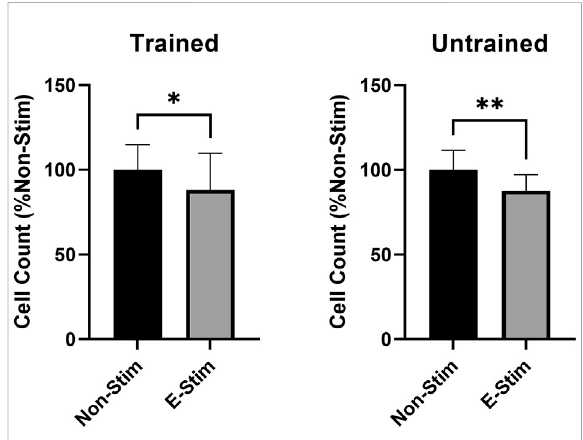
HabitualexercisedoesnotaltertheeffectofE-Stimperfusate on breast cancer cell growth. E-Stim perfusates gathered from both trained and untrained animals led to similar reductions